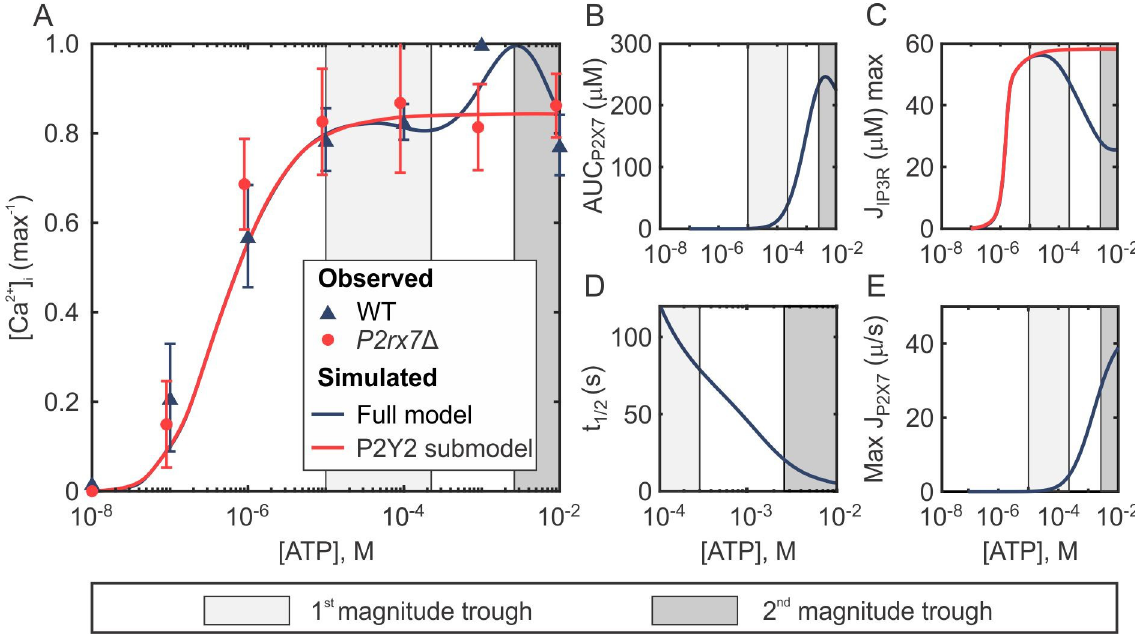
Fig 6. Interaction between P2Y2R and P2X7R underlies the non-monotonic magnitude dose-dependency. (A) The magnitude dose- responses of ATP-induced [Ca 2+ ] i elevations. Markers indicate experimental means ± SEM in wild-type (WT; blue ) and P2rx7 Δ ( red ) C2-OB cells. Curves indicate simulated data generated by the full model ( blue ) and P2Y2 submodel ( red ). (B) P2X7R-mediated Ca 2+ entry estimated from simulated area under the P2X7R flux curve (0–10 s). (C) Simulated maximal flux through IP 3 Rs in the full model ( blue ) and P2Y2 only submodel ( red ). (D) Rate of P2X7R desensitization estimated from simulated time required for P2X7R flux to decay to half of its maximum. (E) Simulated maximum flux through P2X7Rs. Shaded regions in all panels : characteristic first ( light grey ) and second ( dark grey ) magnitude troughs observed in WT cells that disappear in P2rx7 Δ